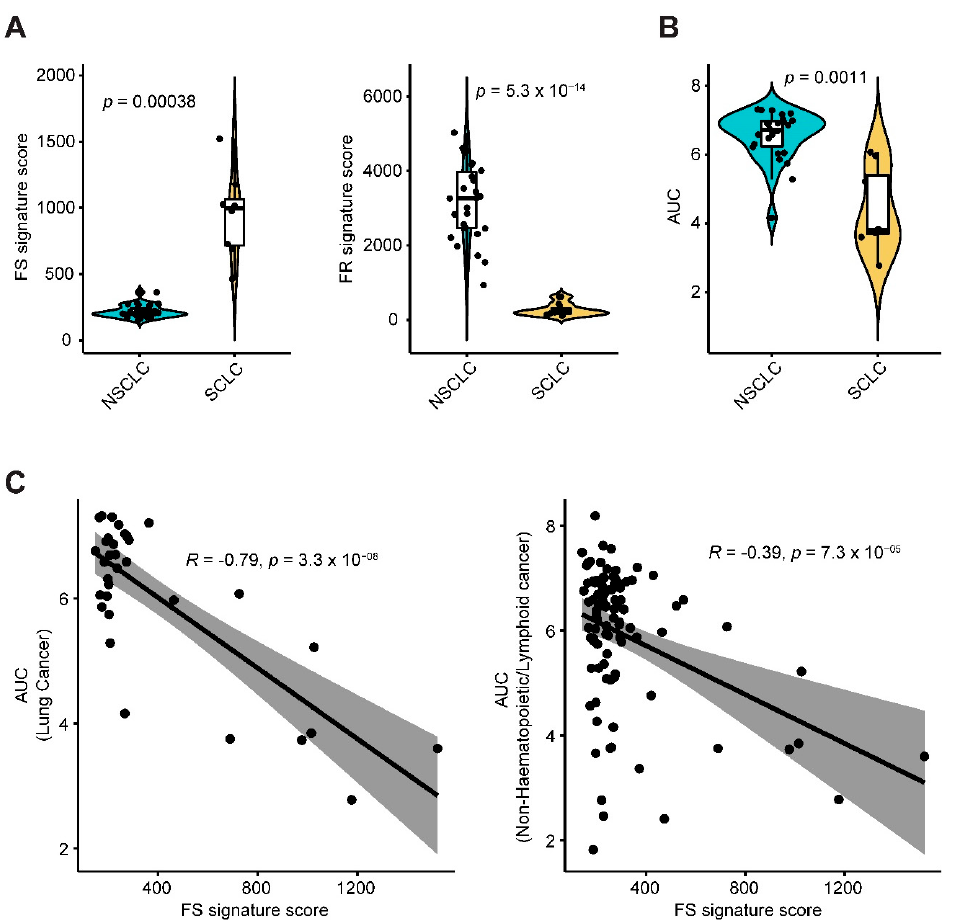
Figure 7. FS and FR gene signatures predict cancer cell responses to Erastin. ( A ), Violin plot shows a significant difference (by unpaired two-sided t-test) of ferroptosis sensitivity (FS) and resistance (FR) signature scores between small cell lung cancer (SCLC) and Non-SCLC (NSCLC). Normalized transcriptomic data of these cell lines were downloaded from Cancer Cell Line Encyclopedia (CCLE) project (https: // portals.broadinstitute.org / ccle). FS and FR gene signatures were scored across a panel of non-hematopoietic / lymphoid-derived cancer cell lines ( n = 99) treated with Erastin, which were downloaded from an independent study cohort (Reference 4). ( B ), Violin plot shows a significantly lower AUC (area under the curve) value in SCLC in response to Erastin than that of NSCLC (by unpaired two-sided t-test) . Of note, lower AUC values indicate more sensitivity or less resistance to Erastin. AUC values of Erastin were downloaded from an independent study cohort (Reference 4). ( C ), A significantly negative correlation between FS score and AUC of Erastin across lung cancer and non-hematopoietic / lymphoid-derived cancer cell